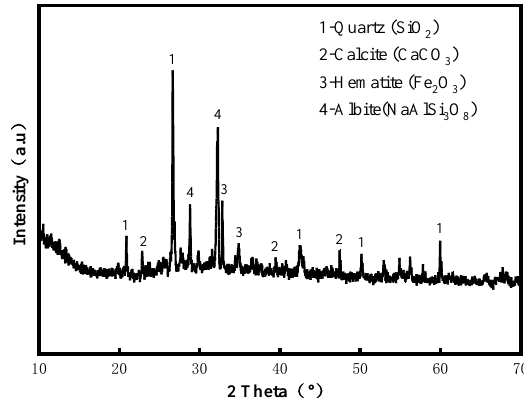
Table 2. ICP-OES ion analysis results.